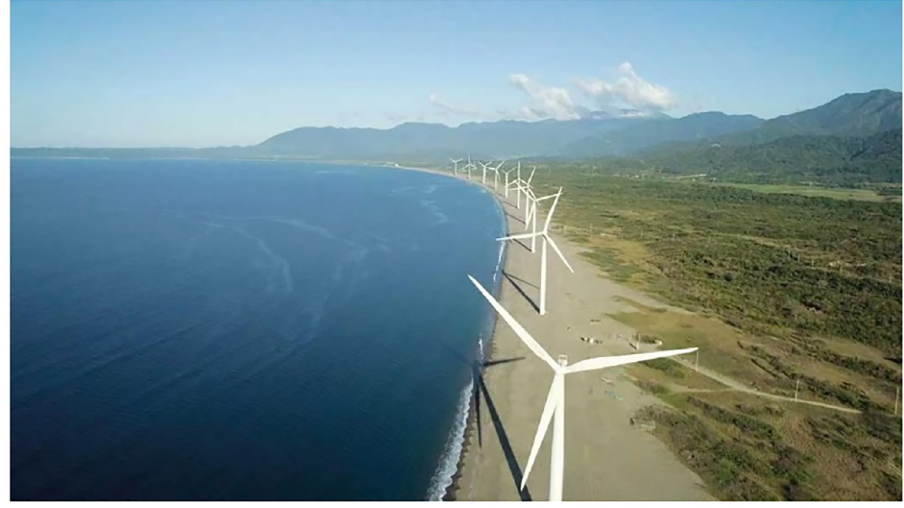
Fig 1. Wind power farm of Cox’s Bazar Bangladesh.